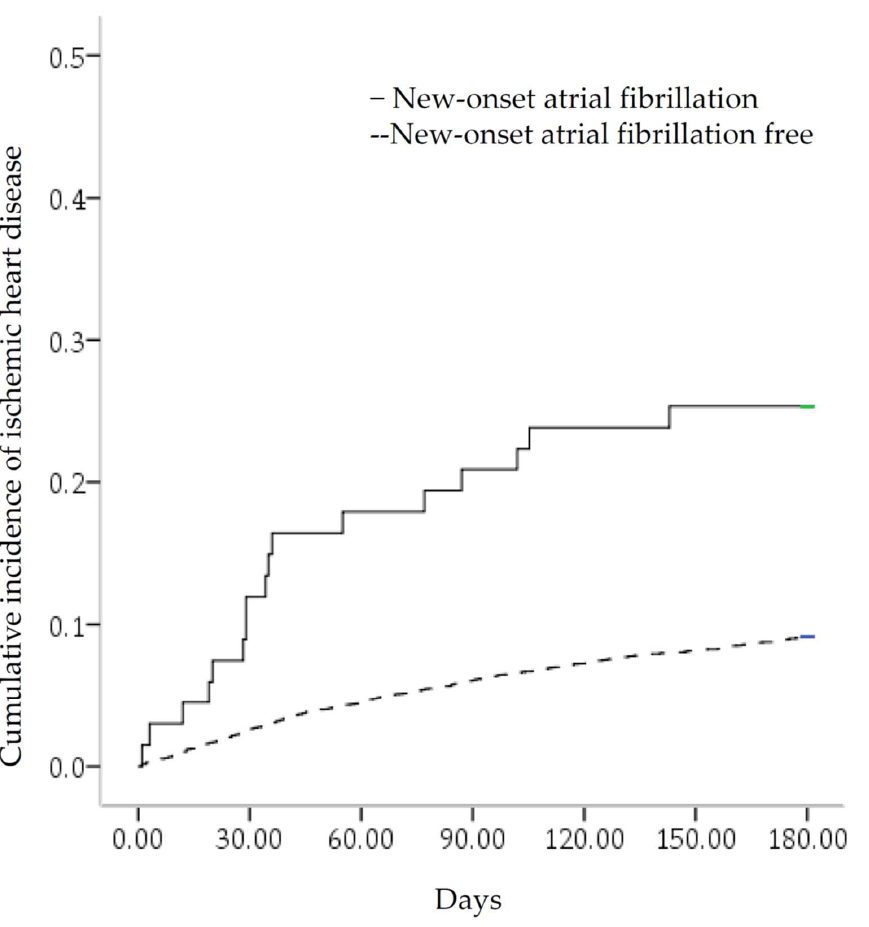
Figure 2. Kaplan–Meier curve for the cumulative incidence of ischemic heart disease. It was stratified by new-onset atrial fibrillation with a log-rank test of p < Table 1. Baseline characteristics of the study subjects.